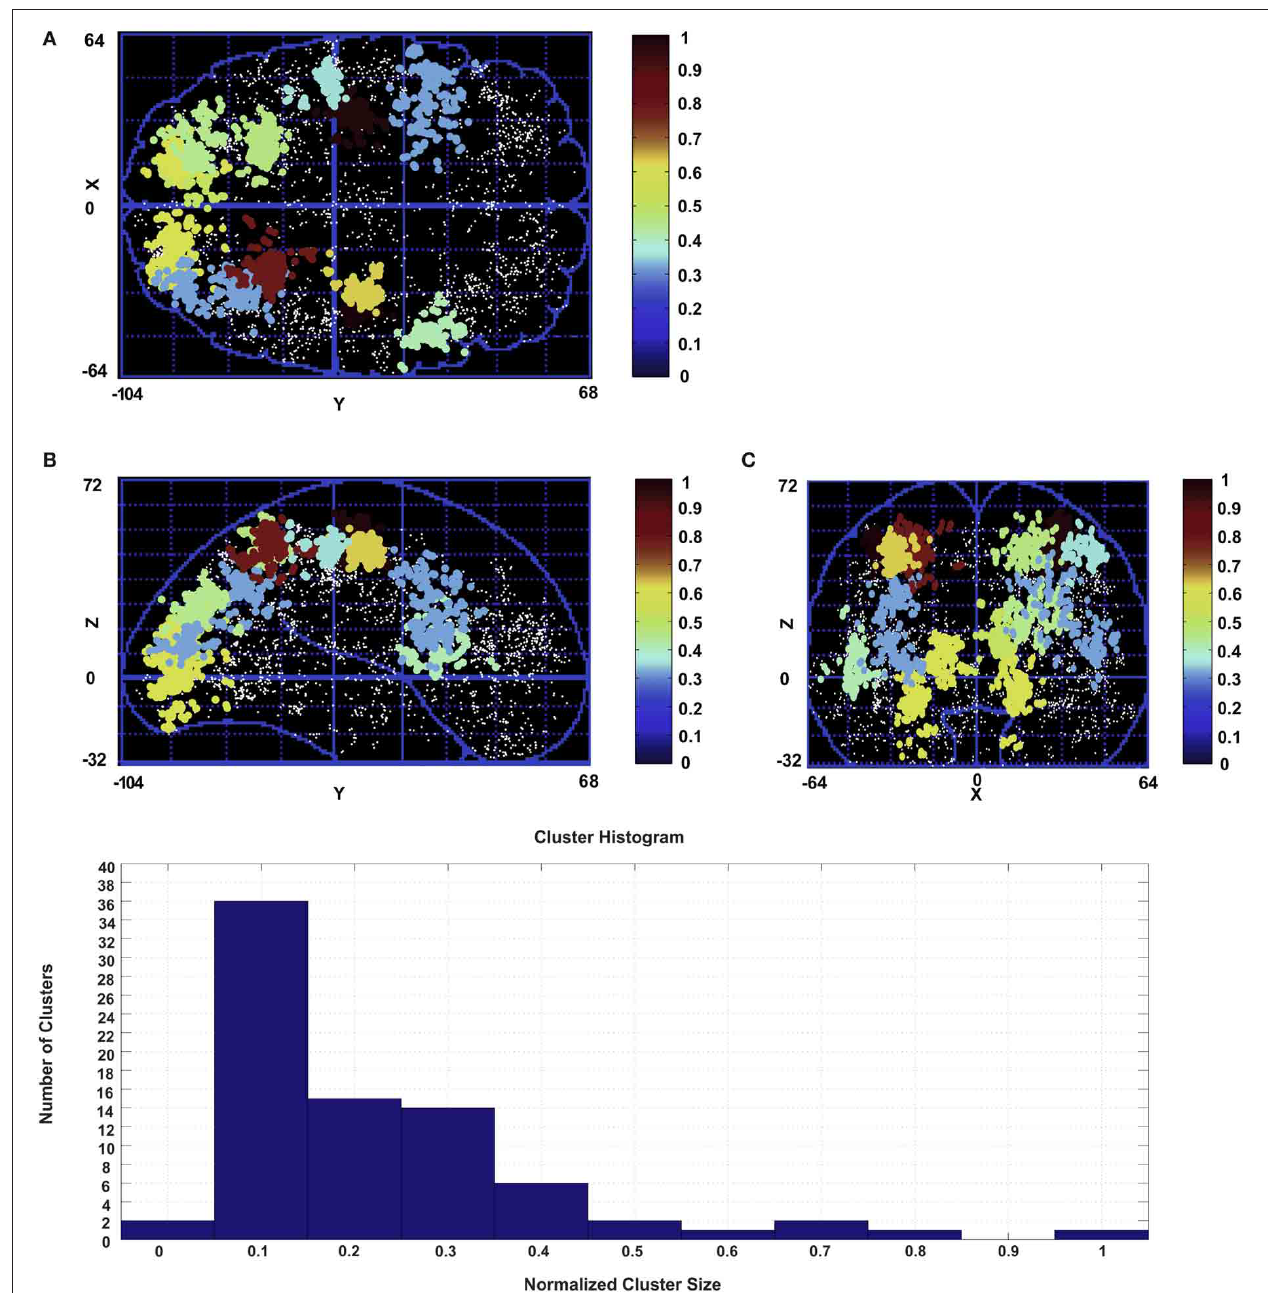
FIGURE 4 | Clusters emerged from the Affinity Propagation algorithm for subject 1. Only the clusters with the number of peaks greater than 28 . 5% of the biggest cluster (397 peaks) are shown. Clusters are color coded according to their number of peaks with